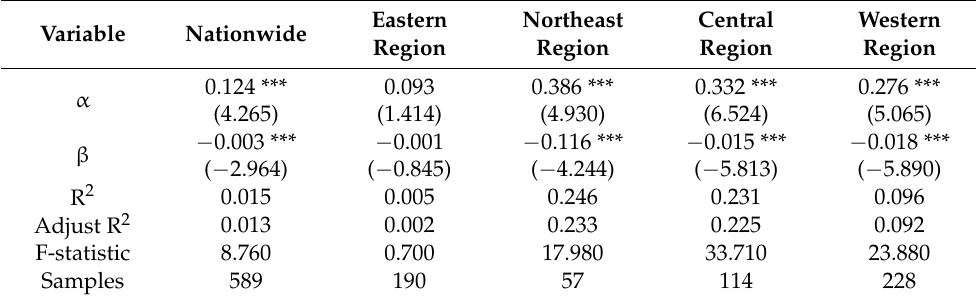
Table 2. Absolute β -convergence results of the flow intensity of virtual cultivated land in China’s mainland